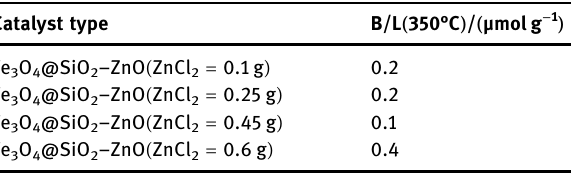
Table 3: Acid load distribution with di ff erent loadings